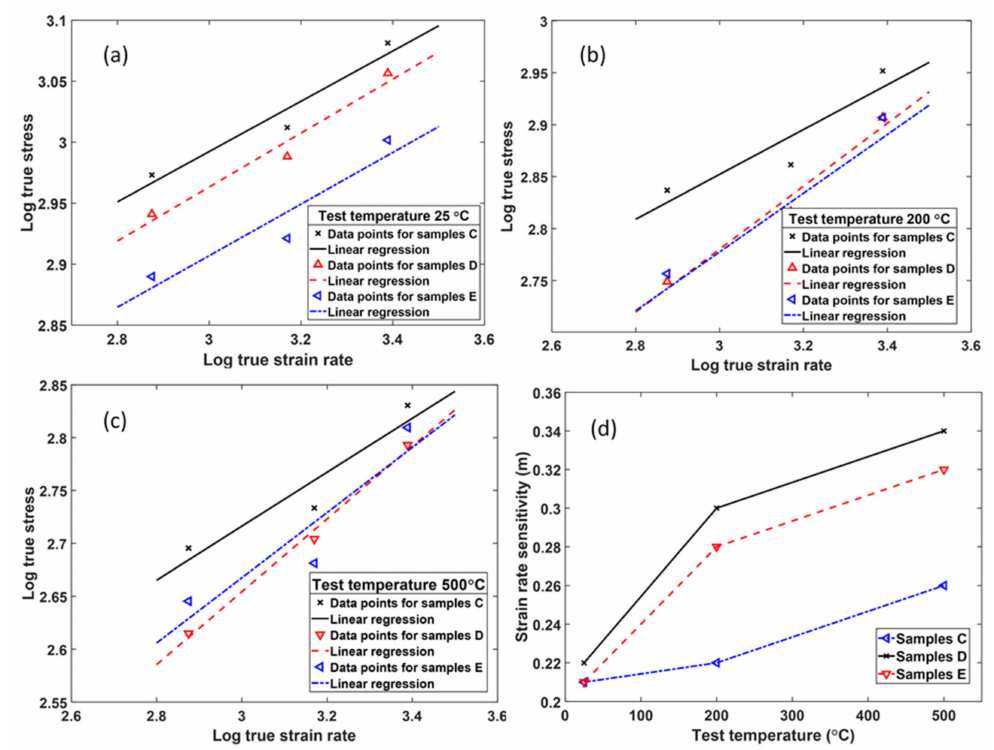
Figure 11. Plots ( a – c ) true stress vs. true strain rate on a log-log scale at a true strain of 0.1, at different test temperatures and ( d ) the variation of the strain rate sensitivity parameter m with temperature for samples C, D and